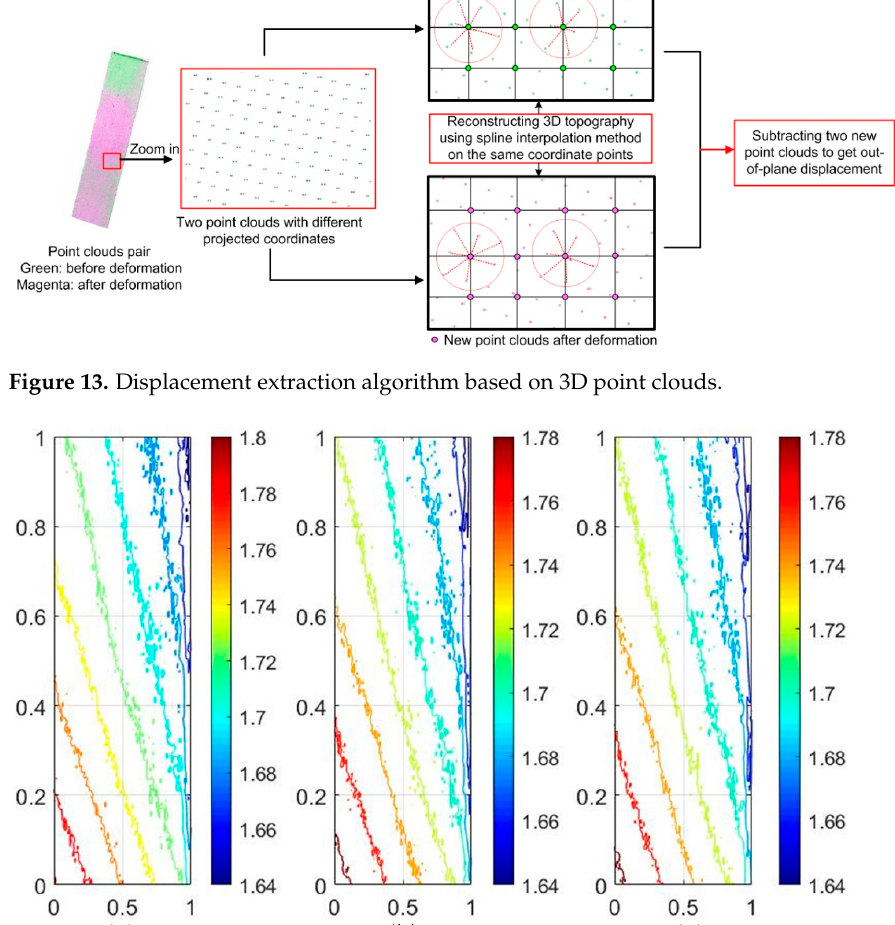
Figure 14. Depth contour of S1 (unit: cm):( a ) F = 200N, ( b ) F = 800N, ( c ) F = 1200N.